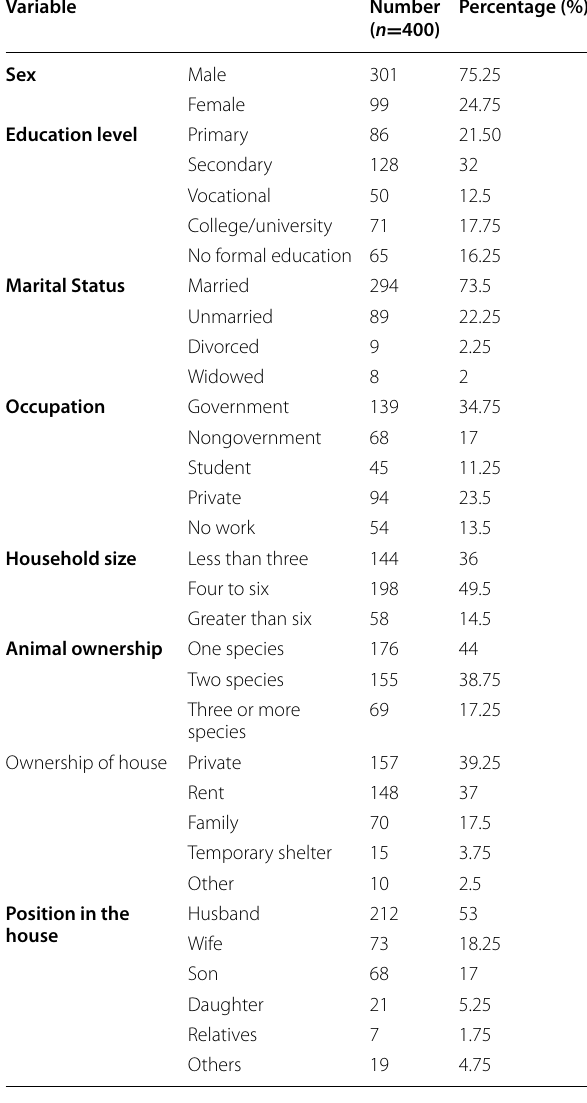
Table 1 Sociodemographic characteristics of study participants